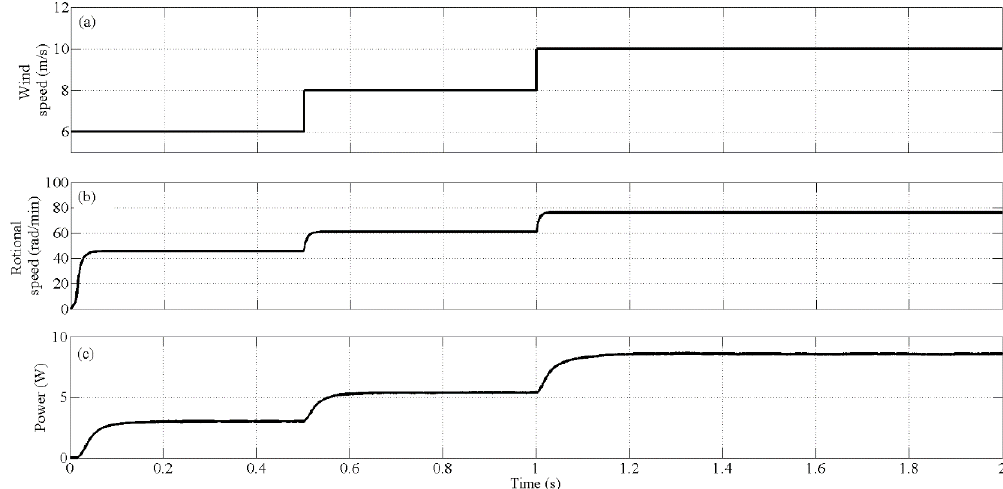
Figure 9. The simulation results of (a) the wind speed, (b) wind turbine output power and (c) rotational speed of wind turbine at abrupt wind speeds.